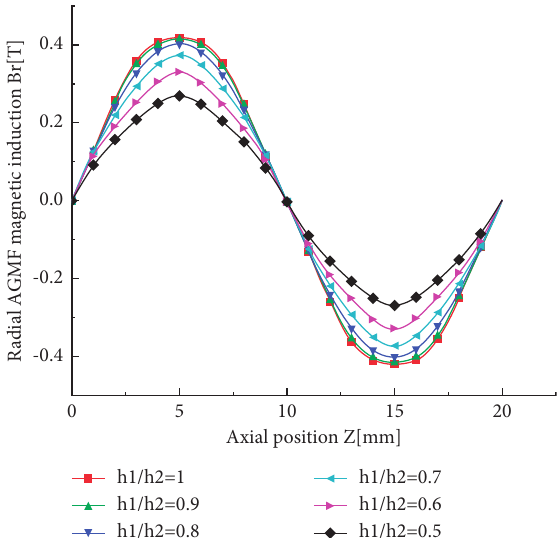
Figure 7: Magnetic induction intensity of radial AGMF at different h 1 / h 2 .